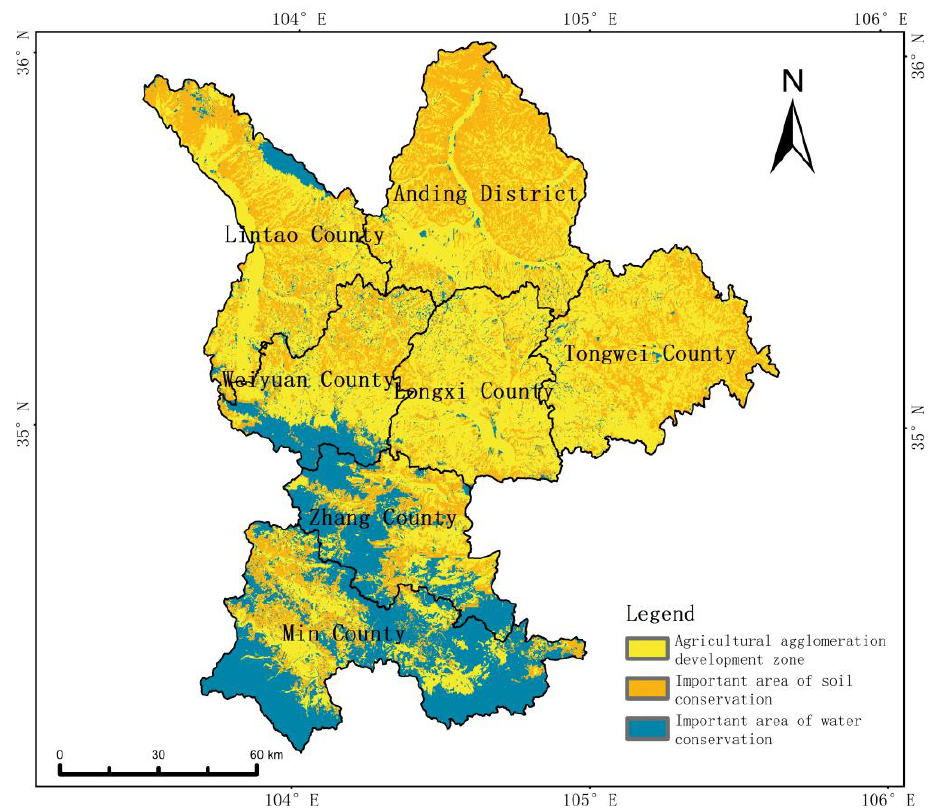
Figure 7. Spatial layout of agricultural production and ecological protection functions.